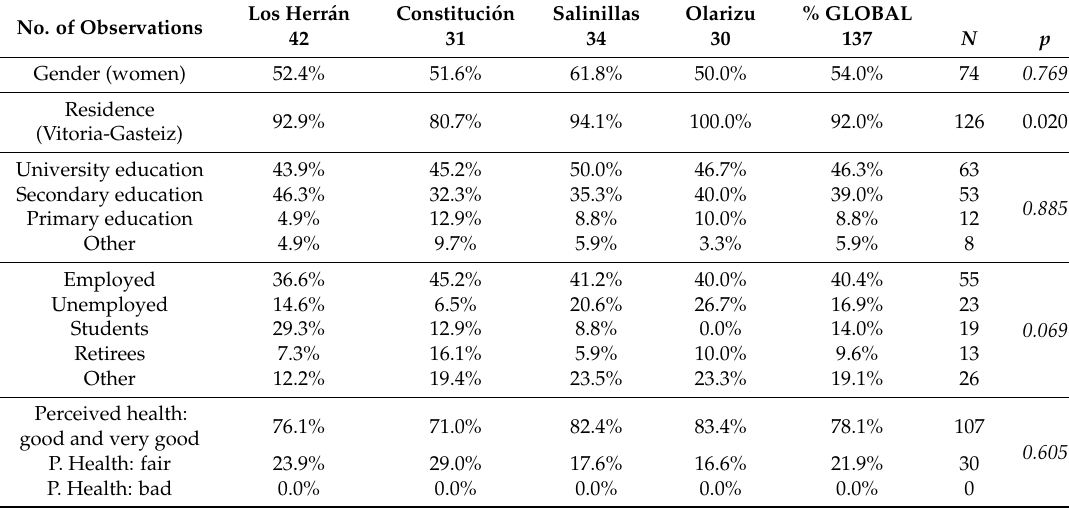
Table 2. Participant characteristics by urban places in Vitoria-Gasteiz (total), and significance ( p ) of Chi-square